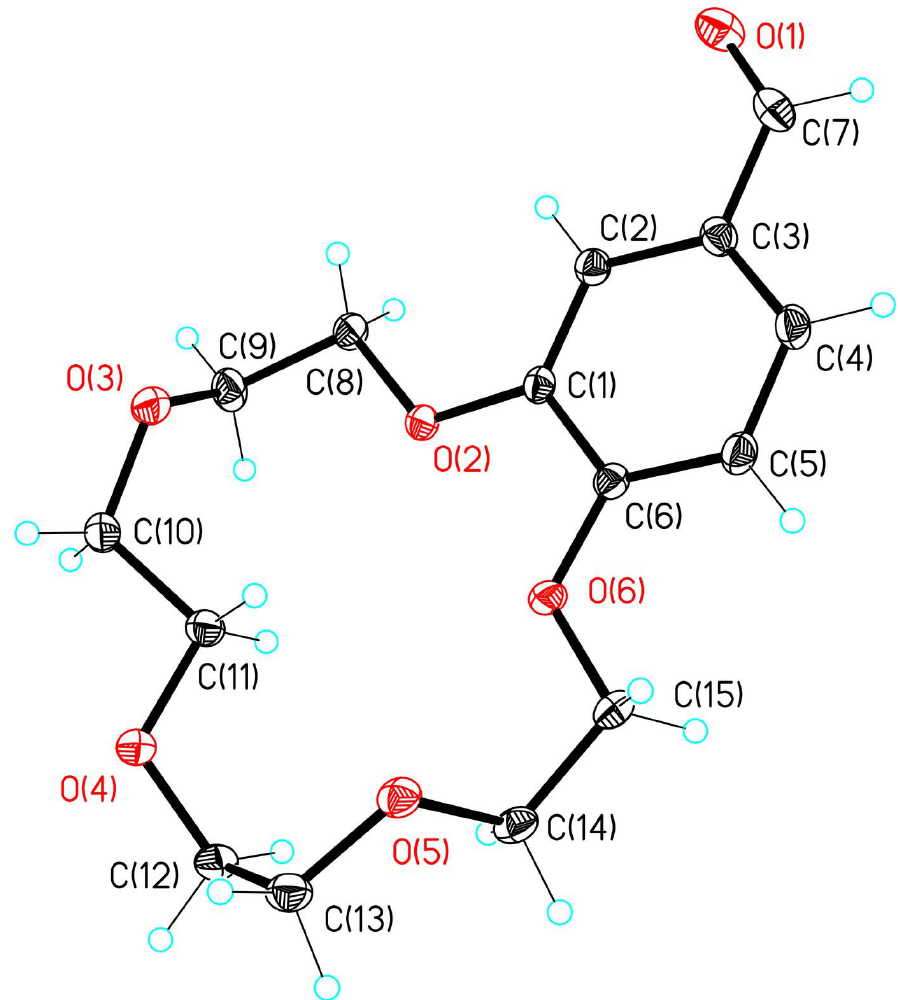
Figure 1 Molecular structure of the title compound with ellipsoids drawn at the 50% probability